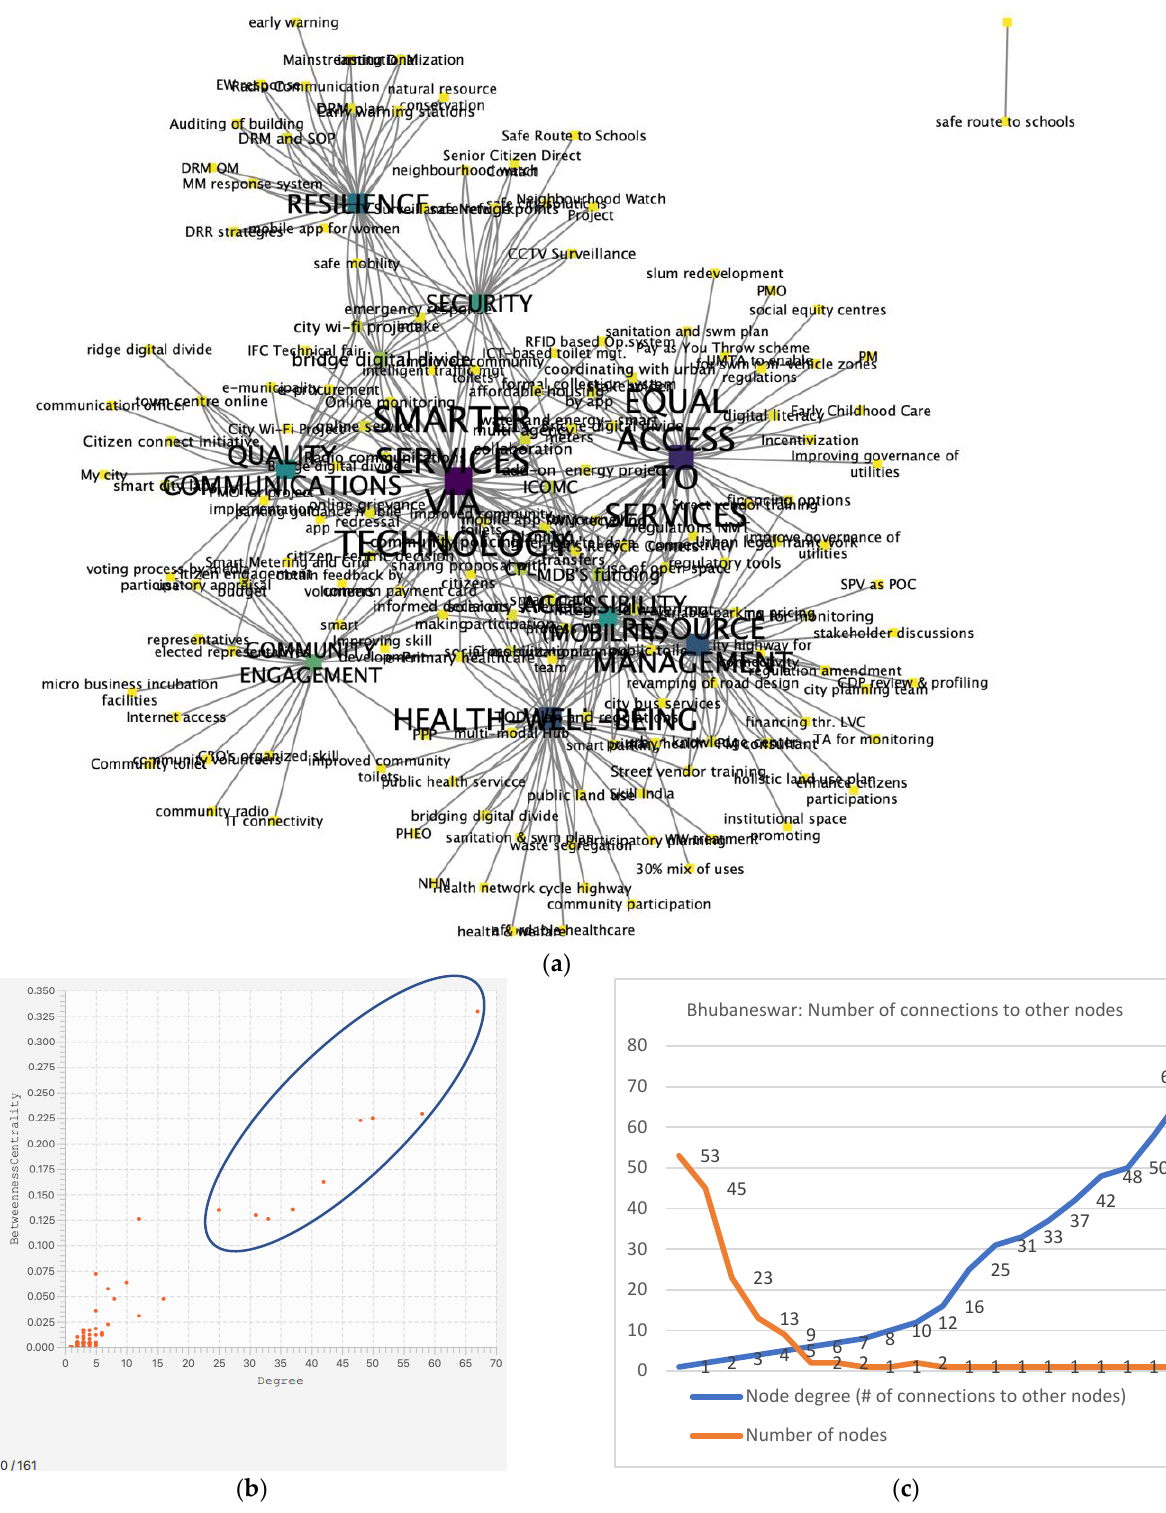
Figure 2. ( a ): Bhubaneswar — soft asset value elements, soft asset capitals, and activities/initiatives (image via Cytoscape, https://cytoscape.org (accessed on 4 January 2022)); ( b ): Node degree distri- bution; ( c ) Number of connections to other nodes.